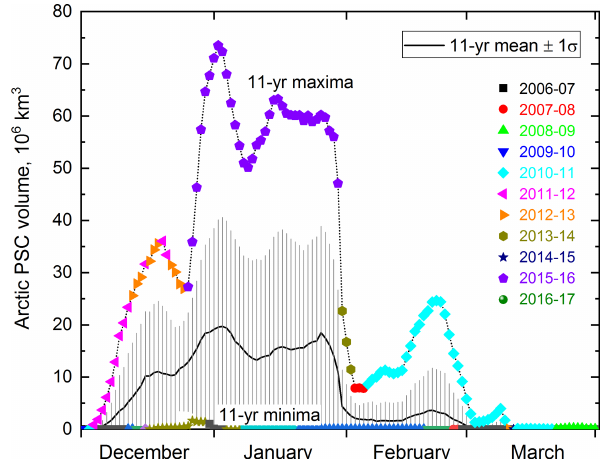
Figure 22. Time series of the 11-year mean, standard deviation, and range of daily values of Arctic PSC spatial volume (daily areal cov- erage integrated over altitude). The daily maximum and minimum values are color-coded according to the year in which they